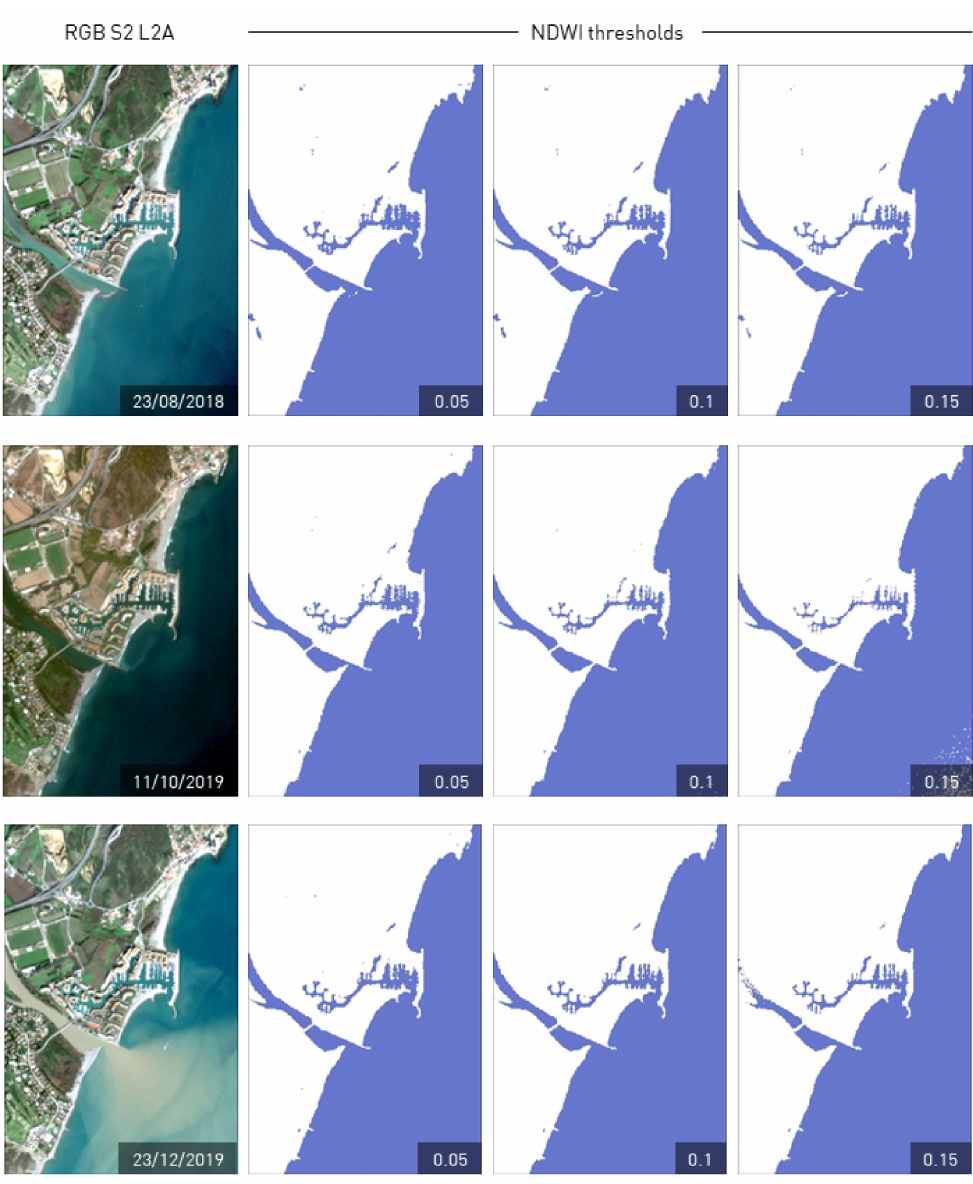
Figure A1. NDWI thresholding test showing 0.1 value as optimal. Image from 23 August 2018 shows the delineation of an additional sand bar; second image (11 October 2019) shows the detection of the sand spit closing the river mouth; and last image (23 December 2019) shows how scenarios with high turbidity do not interfere in water and non-water pixel